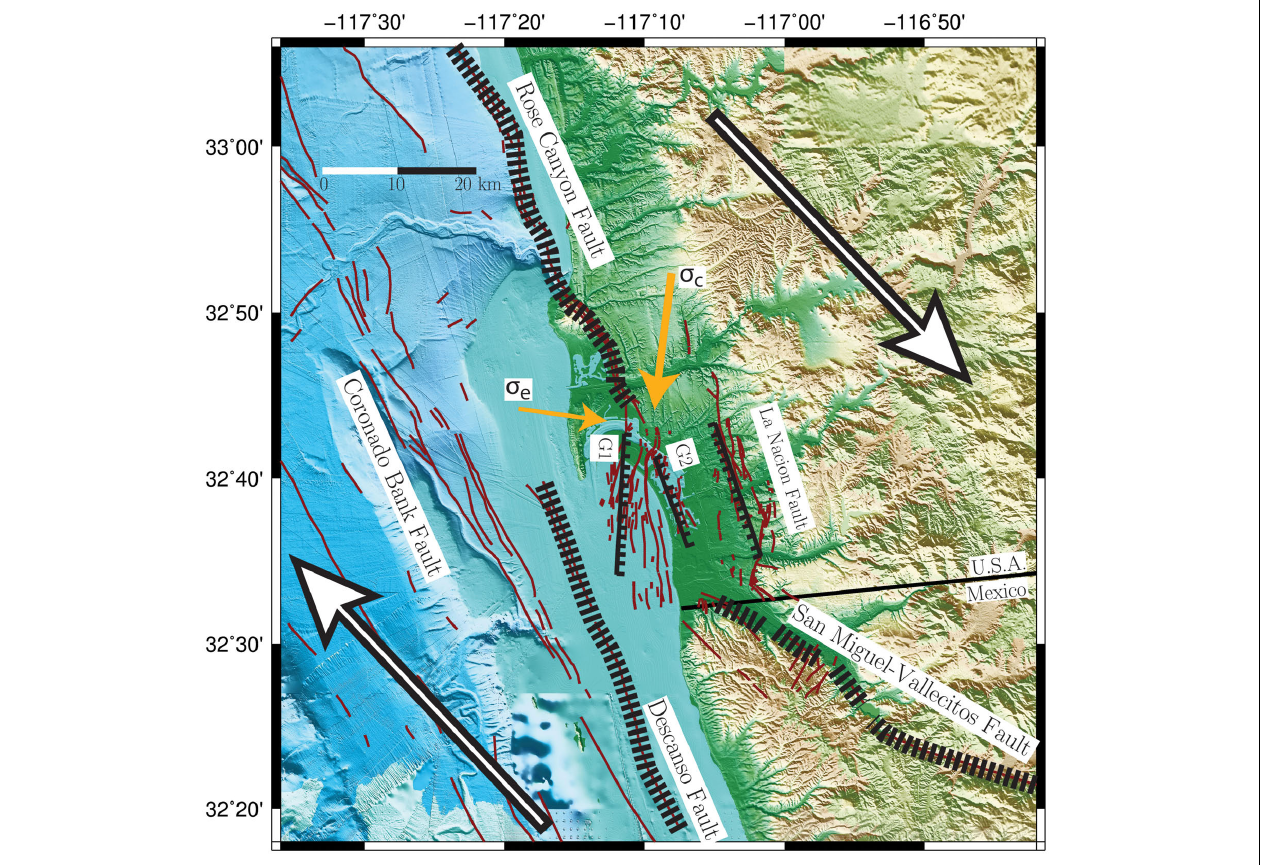
FIGURE 13 | Regional fault orientations and plate boundary parameters used for kinematic analysis and interpretation. Solid orange arrows are maximum and minimum horizontal stress orientations, σ c and σ e , respectively (Hardebeck and Hauksson, 2001), large black and white outlined arrows are plate motion vectors, and the average orientations for Group-1, Group-2, and La Nacion fault zones are solid black, toothed lines. Large black hatched lines are regional faults. G1, Group 1; G2, Group 2. Background fault traces (thin red lines) are from USGS Quaternary fault database (USGS, 2019). Background topography and bathymetry are from the National Centers for Environmental Information Southern California Coastal Relief Model (v2) (Calsbeek et al., 2013). Figure created using Generic Mapping Tools (Wessel et al.,